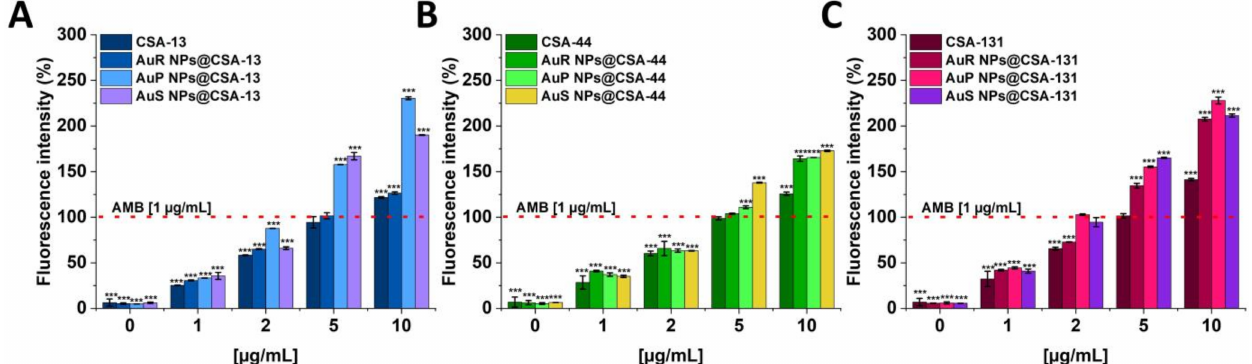
Figure 6. Depolarization of the fungal membrane of C. albicans 1408 cell fungal membrane was assessed using diSC (3) assay. The evaluation of the degree of cell membrane depolarization in the presence of CSA-13, AuR NPs@CSA-13, AuP NPs@CSA-13, AuS NPs@CSA-13 ( A ); CSA-44, AuR NPs@CSA-44, AuP NPs@CSA-44, AuS NPs@CSA-44 ( B ); and CSA-131, AuR NPs@CSA-131, AuP NPs@CSA-131, AuS NPs@CSA-131 ( C ) ranging from 1 to 10 µ g/mL was evaluated by monitoring the enhancement of intensity of the fluorescence. The dashed line represents the effect obtained with the amphotericin B at a concentration of 1 µ g/mL. Results show the mean ± SD, n = 3; *** indicates statistical significance at ≤